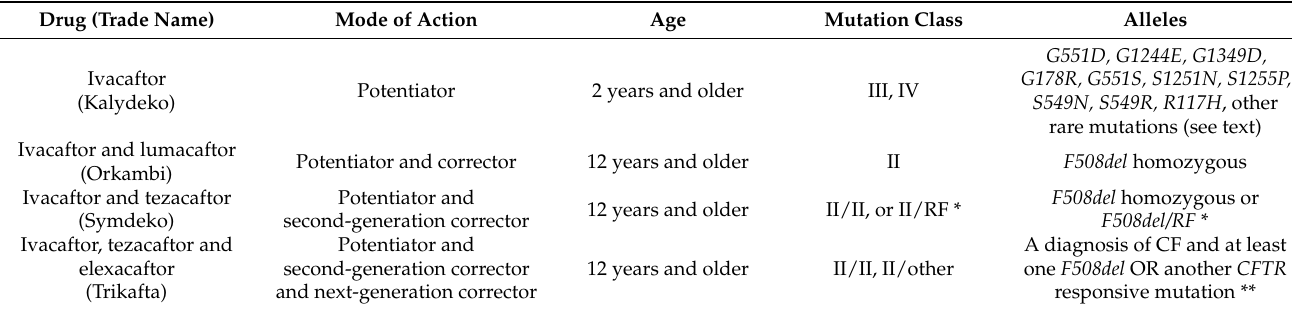
Table 1. FDA-approved CFTR modulators and indications for use in CF